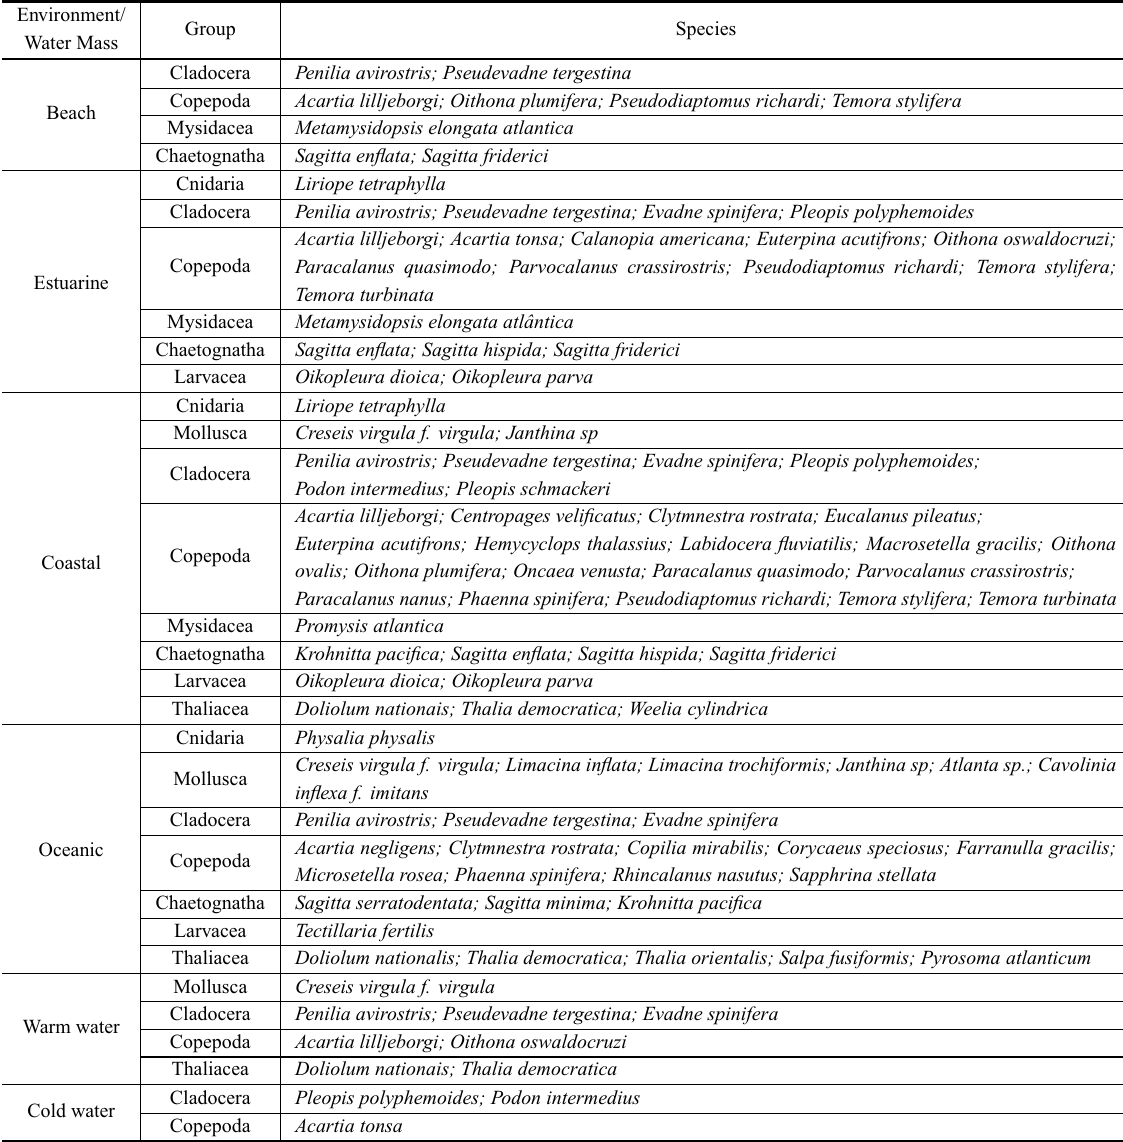
Zooplankton species by habitat and physical-chemical preferences of water